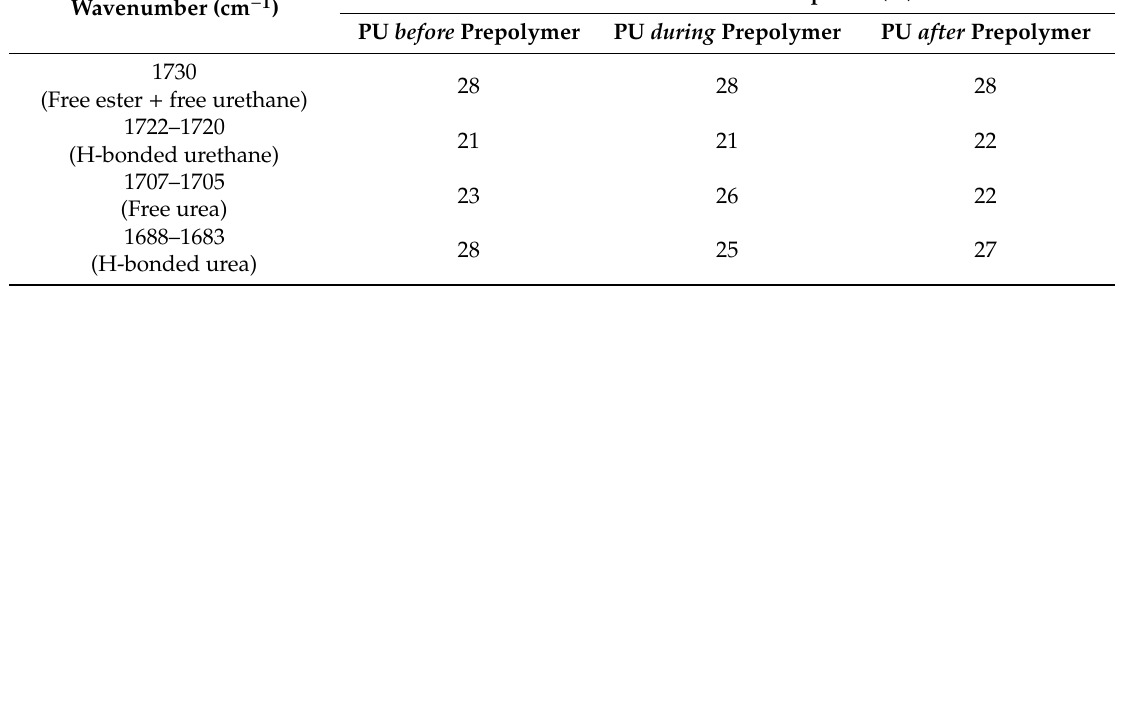
Table 3. Contributions of the di ff erent carbonyl species of the PU films. Curve fitting of the carbonyl region of the ATR-IR spectra.